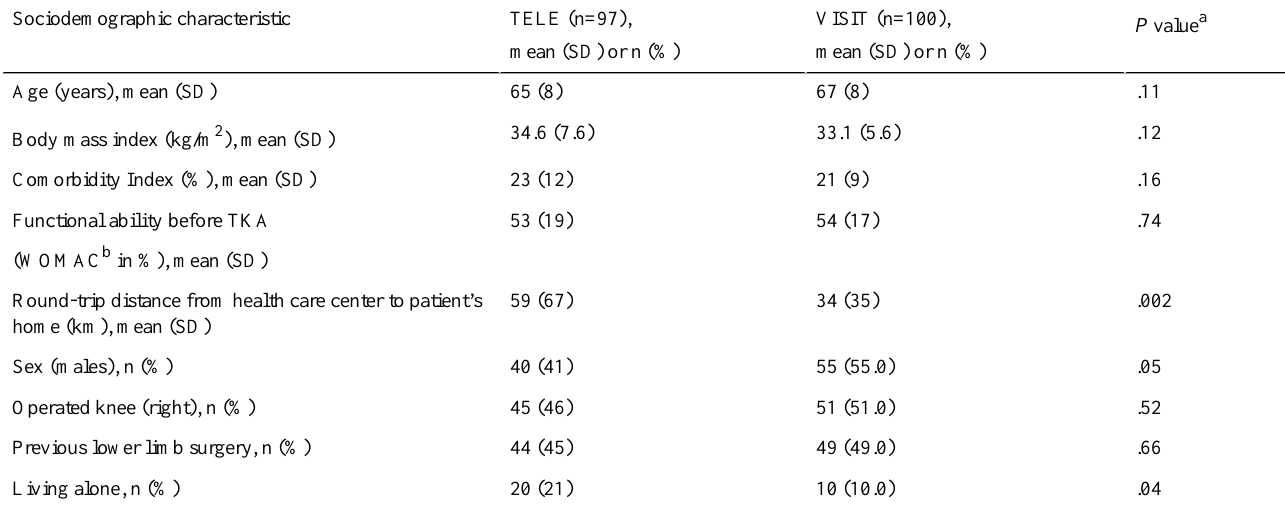
Table 2. Descriptive statistics at baseline of the sample included in the cost analysis